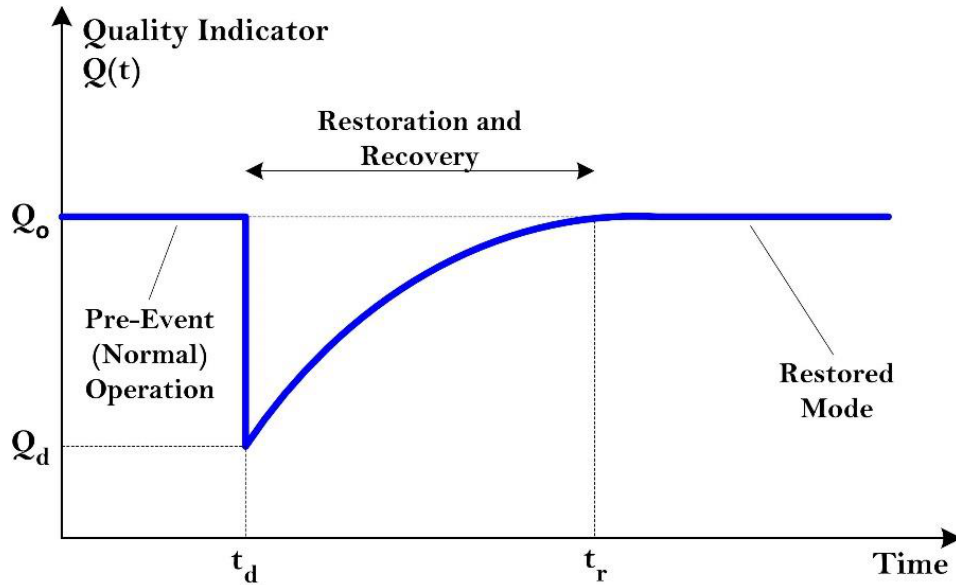
Figure 4. Resilience Tringle Curve, adapted from [22]. System degradation occurs at time t d and service is restored at t r . Area under the curve indicates the loss in the quality indicator Q.